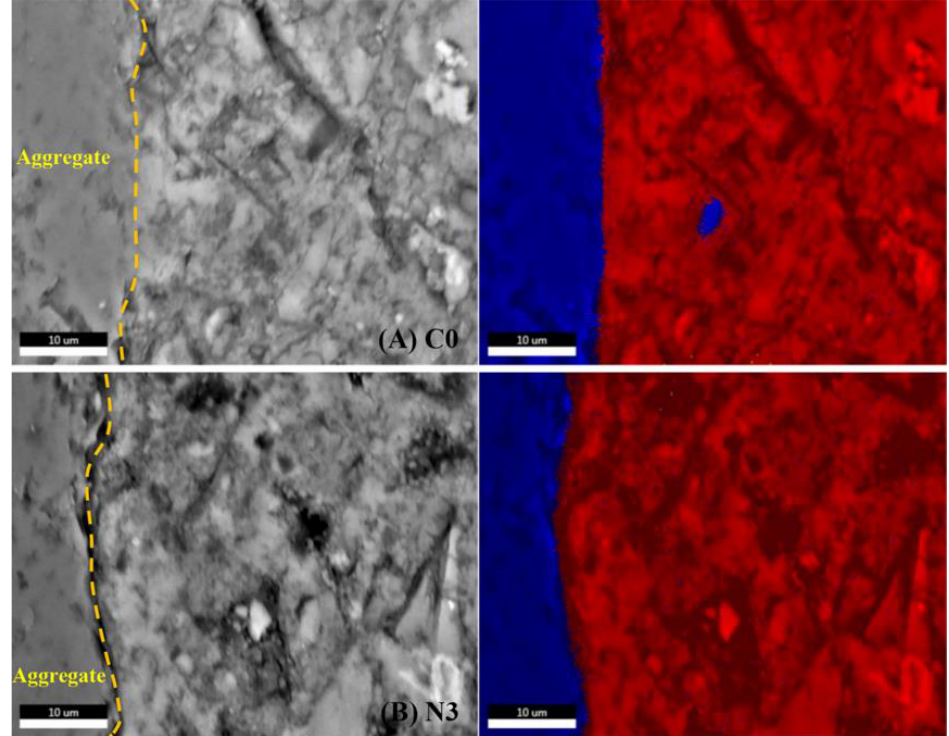
Figure 20. BSE-EDS analysis of ITZ of ( A ) C0 and ( B ) N3 at 28 days. Table 7. Analysis of the element content of ITZ of different mortars.